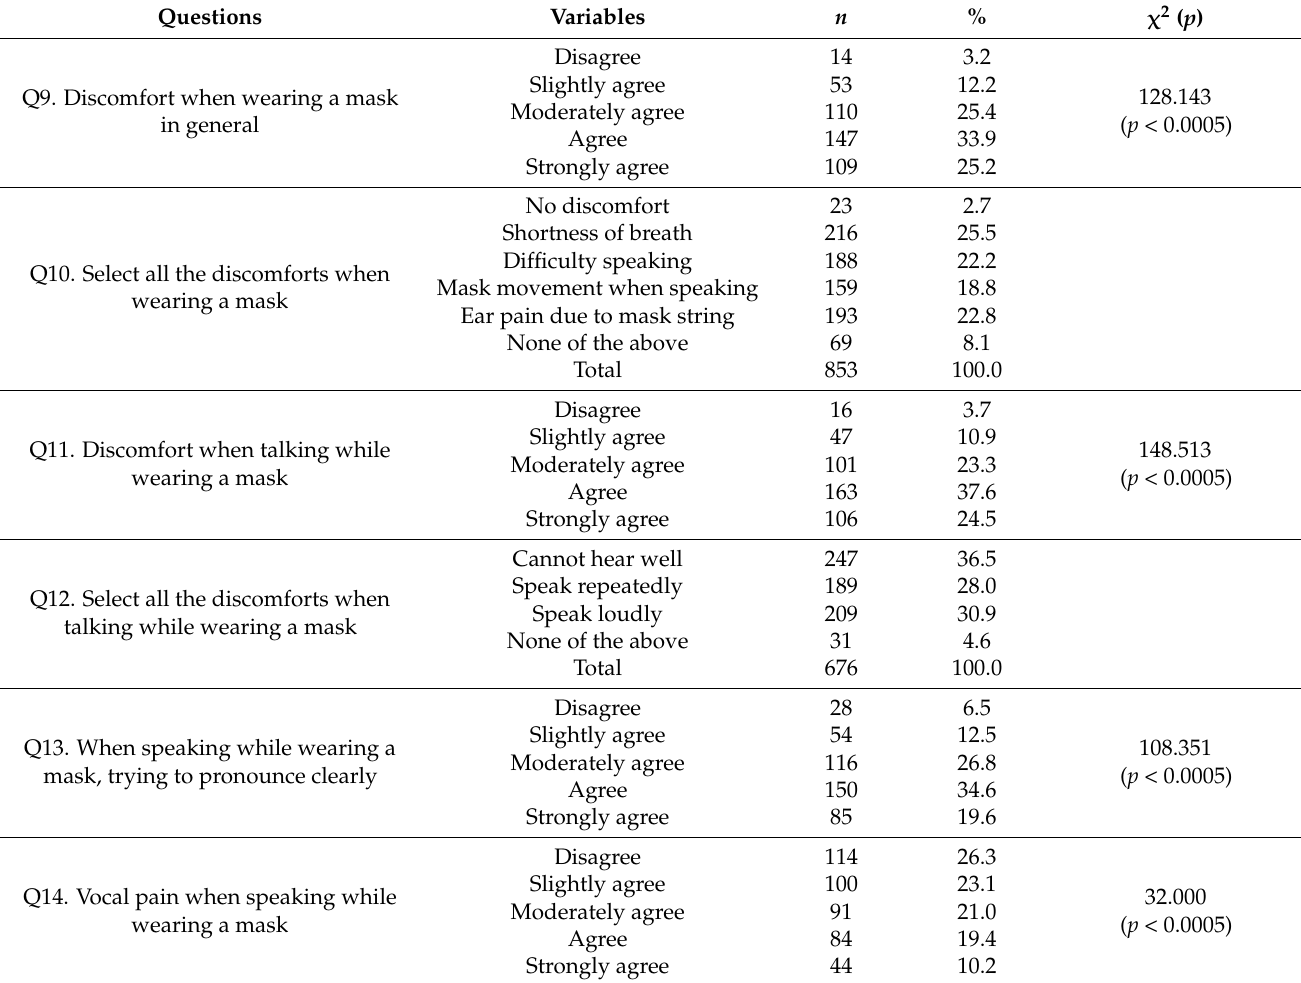
Table 3. Survey results: discomfort due to a face